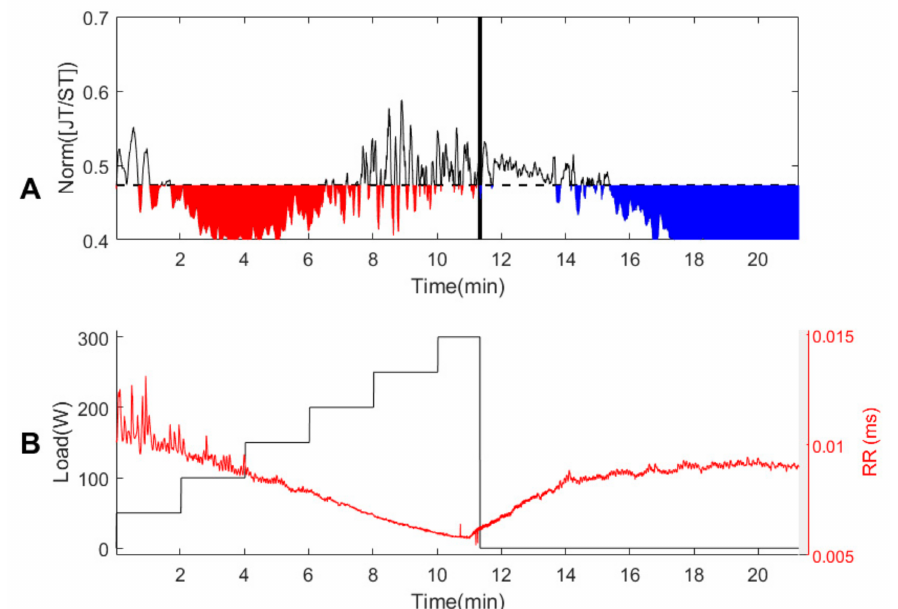
Figure 6. The dynamics of the JT/ST relationship during the load and recovery processes for person #5. The x -axis in parts ( A , B ) represents the time (measured in minutes) from the beginning of the cycle ergometry exercise. The left y-axis in part ( B ) represents the power of the load in Watts. The right y-axis in part ( B ) represents the variation of the RR interval in ms. The algebraic JT/ST relationship is represented by the thin dashed black line in part A. The thick black solid vertical line in part A marks the end of the